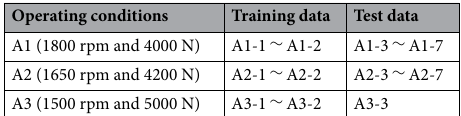
Table 1. The information of FEMTO dataset.